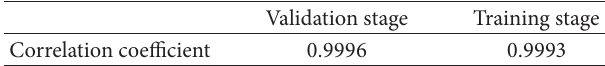
Table 4: Statistical analysis of predicted temperature and the generalized performance of ANN-based model.